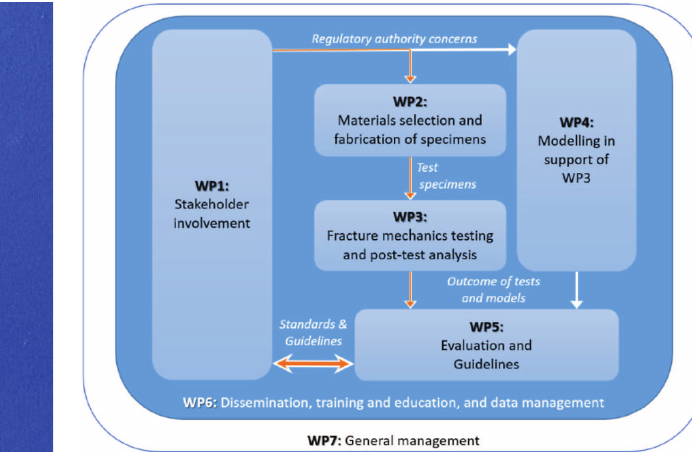
Fig. 5. Standard and miniaturized specimens for FT testing. MCT specimen is the rightmost.